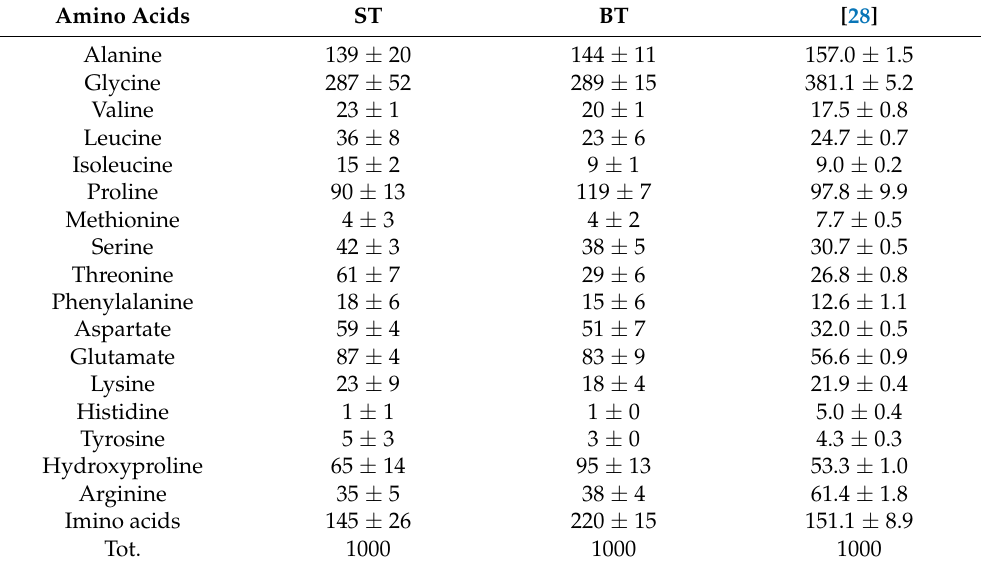
Table 2. Amino acid composition of ST and BT skin in comparison with literature data about Tilapia skin composition. Results are expressed as residues/1000 total amino acid